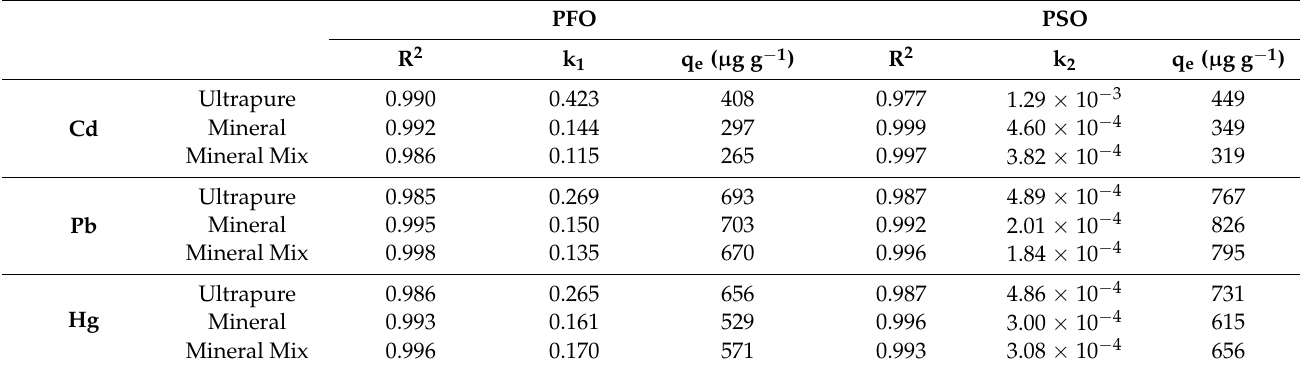
Table 3. Correlation coefficients (R 2 ) and value of q at equilibrium (q e ) retrieved from the pseudo-first (PFO) and pseudo- second (PSO) order kinetic models for each of the experiments with hazelnut shells and cadmium (Cd), lead (Pb) and mercury